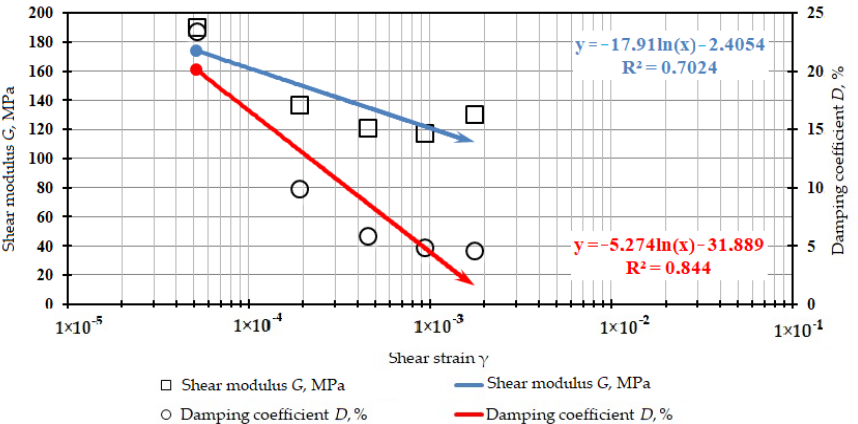
Figure A5. Graph of dependencies of generic shear modulus G/G 0 (unit fractions) and damping coefficient D (%) on the amplitude of shear strains γ (unit fractions) for cement stabilized soils. Test 5 (triaxial dynamic compression).